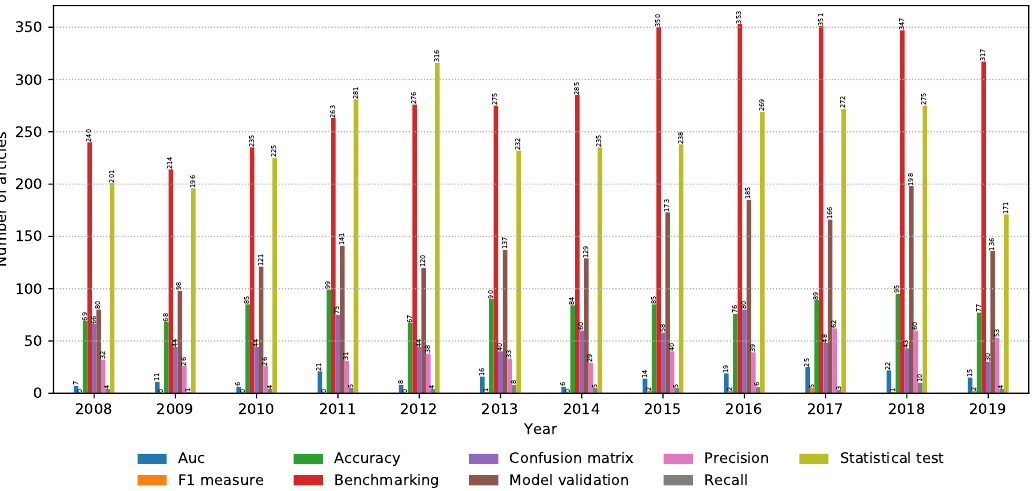
Figure 12. Number of relevant articles containing each property grouped into the model evaluation